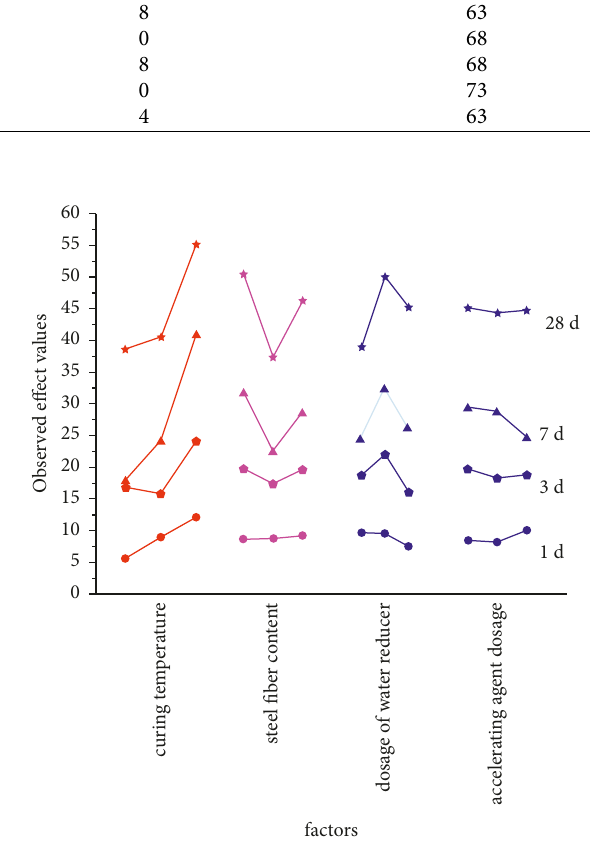
Figure 2: Effect curve fluctuation.